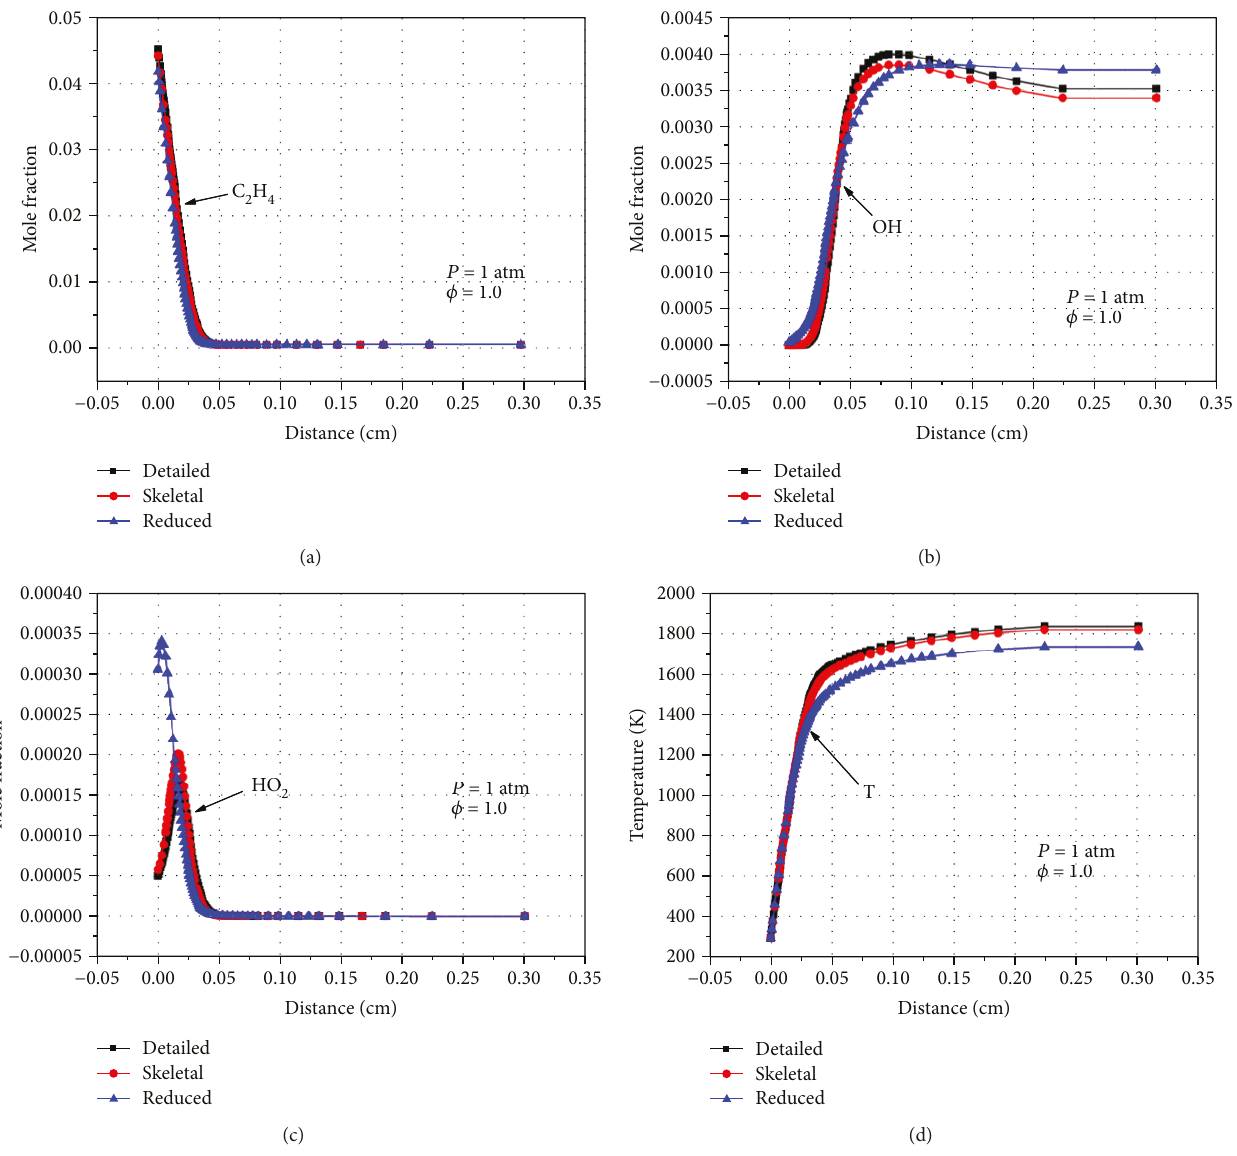
Figure 7: Changes in concentration of various chemical reagents and by-products calculated based on reduced mechanism, skeletal mechanism, and detailed